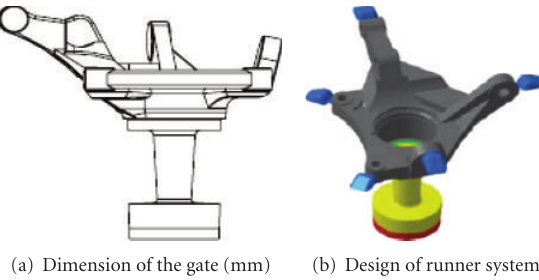
Figure 18: Geometry of gate and runner system for